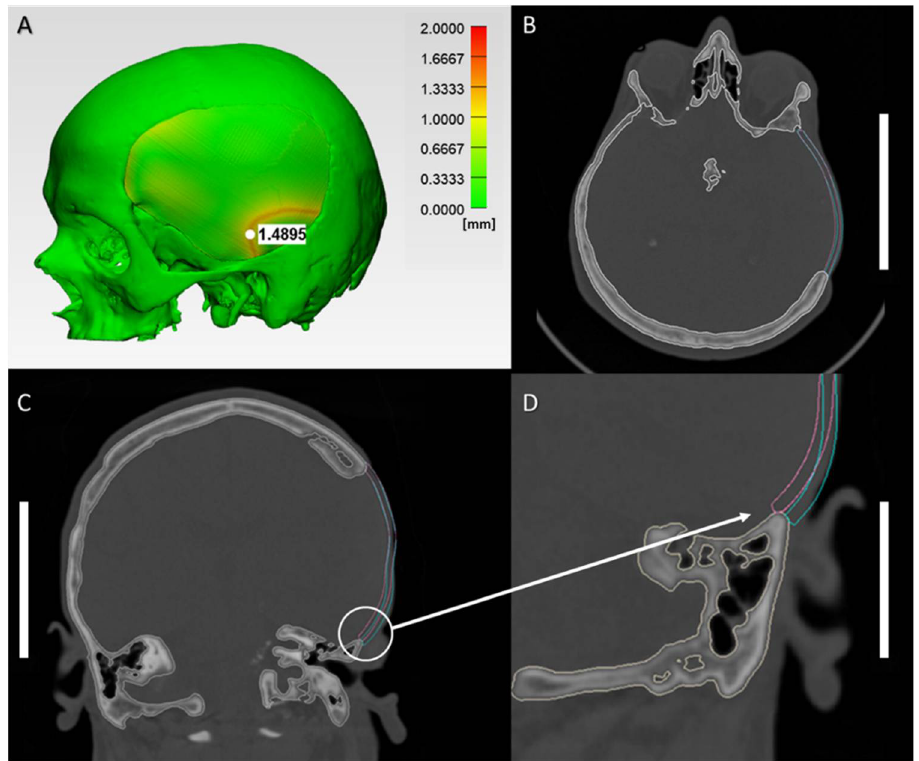
Figure 2. Morphological characteristics in an implant with a “satisfactory” fit and contour continuity: ( A ) Reconstruction contour conformance distance map; ( B ) Axial view illustrating the contour continuity between planned (blue) and 3D-printed (pink) PEEK implant (scale bar, 5 cm); ( C ) Coronal view illustrating the contour continuity between planned (blue) and 3D-printed (pink) PEEK implant (scale bar, 5 cm); ( D ) Magnified sagittal cross-sectional view of the white circled inset illustrating the slight discrepancy in the marginal fit between planned (blue), and 3D-printed (pink) PEEK implant (scale bar, 5 cm).